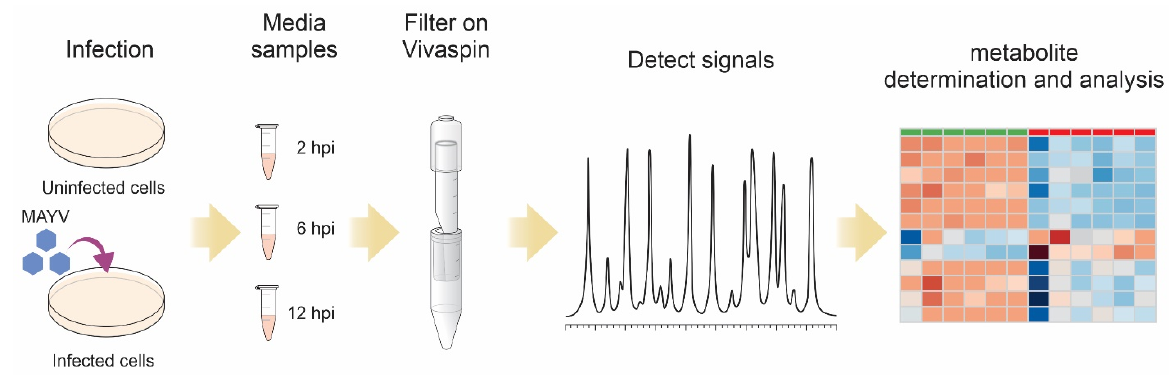
Figure 1. An outline of the approach used in this work. First Vero cell monolayers were infected with MAYV. In 2, 6, and 12 hpi samples were collected and filtered in Vivaspin. The filtrate was used to detect metabolites by NMR.